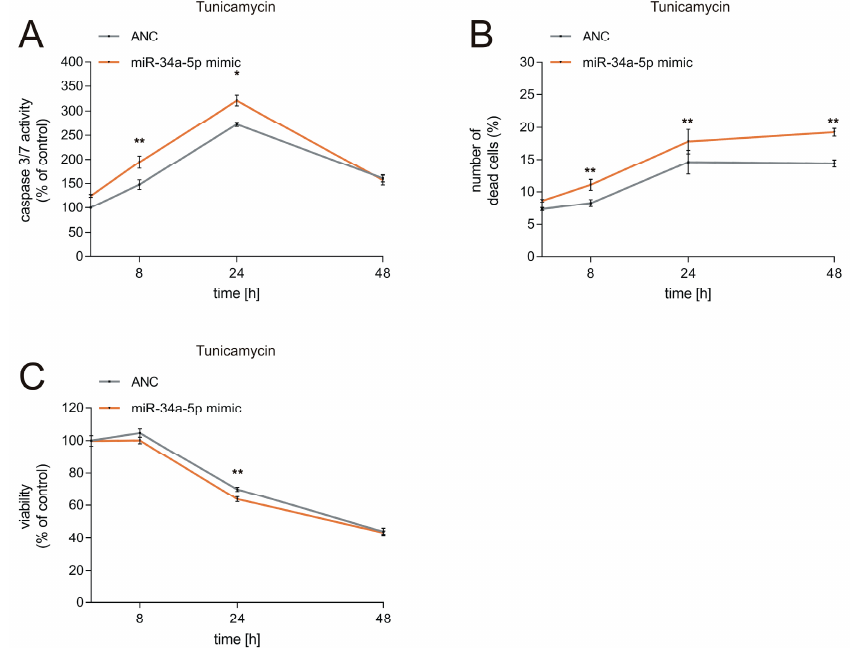
Figure 5. Functional effects of miR-34a-5p targeting on the UPR. ( A – C ) Results of the caspase 3/7 assay ( A ), cytotoxicity assay ( B ) and viability assay ( C ) in miR-34a-5p transfected SH-SY5Y cells treated with tunicamycin. SH-SY5Y cells were transfected with AllStars Negative Control (ANC) or miR-34a-5p mimic and treated with tunicamycin for the indicated times. Caspase 3/7 activity, cytotoxicity, and cell viability were measured by changes in luciferase activity. The experiments were done in triplicate in two independent experiments (* = p ≤ 0.05, ** = p ≤ 0.01).